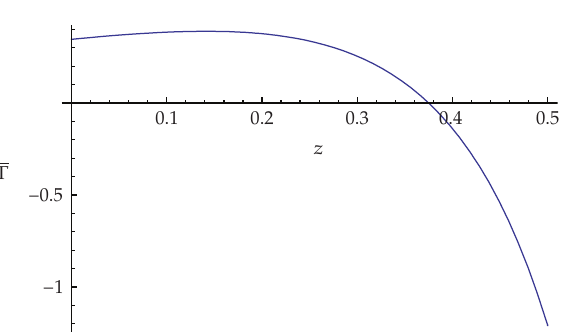
Figure 2: The plot of Γ against z for Ω m 0 (cid:2) 0 . 18 shows that | Γ | < 1, for z < 0 . 45 and so the field starts tracking from that